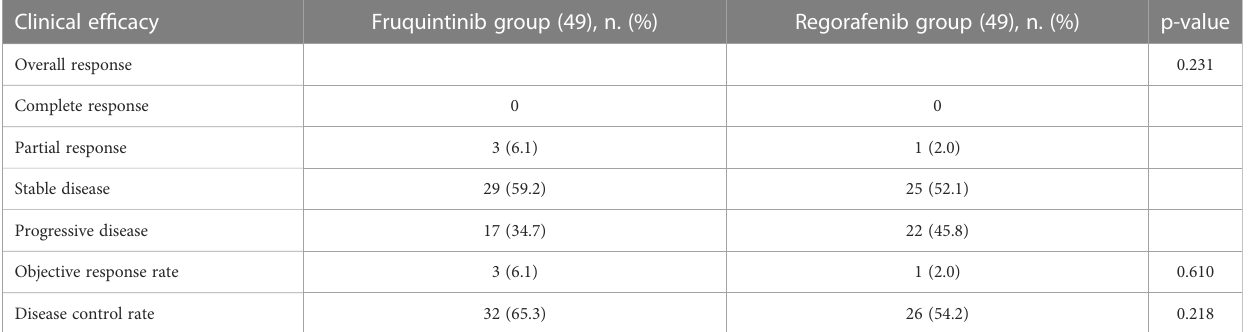
TABLE 2 Curative effect